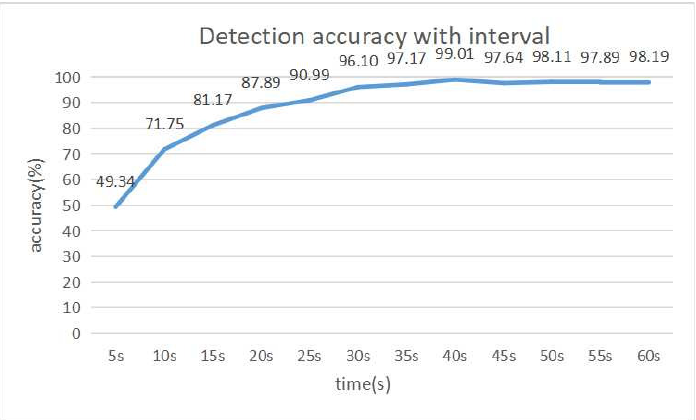
Figure 4. Detection accuracy with interval